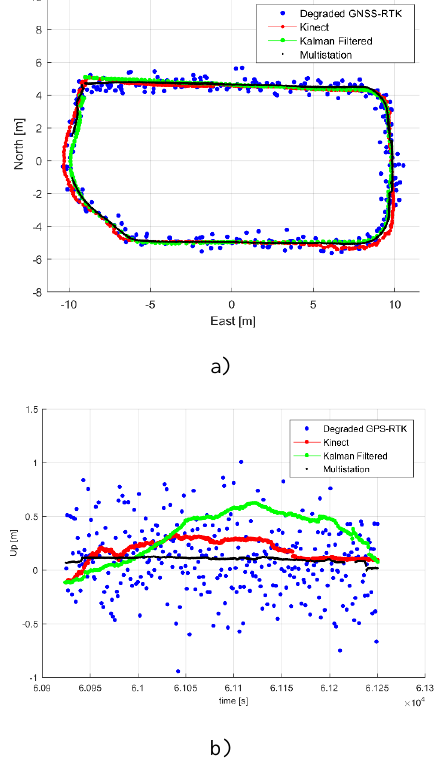
Figure 8. The computed solutions: a) planimetric view of the estimated trajectories – b) height behaviour of the estimated trajectory over time